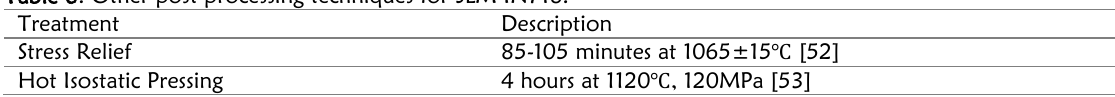
Figure 19: Distortion of a tensile bar due to residual stress. Sectioning of SLM’ed Inconel 718 by wire electrical discharge machining. Table 6. Other post-processing techniques for SLM IN718.